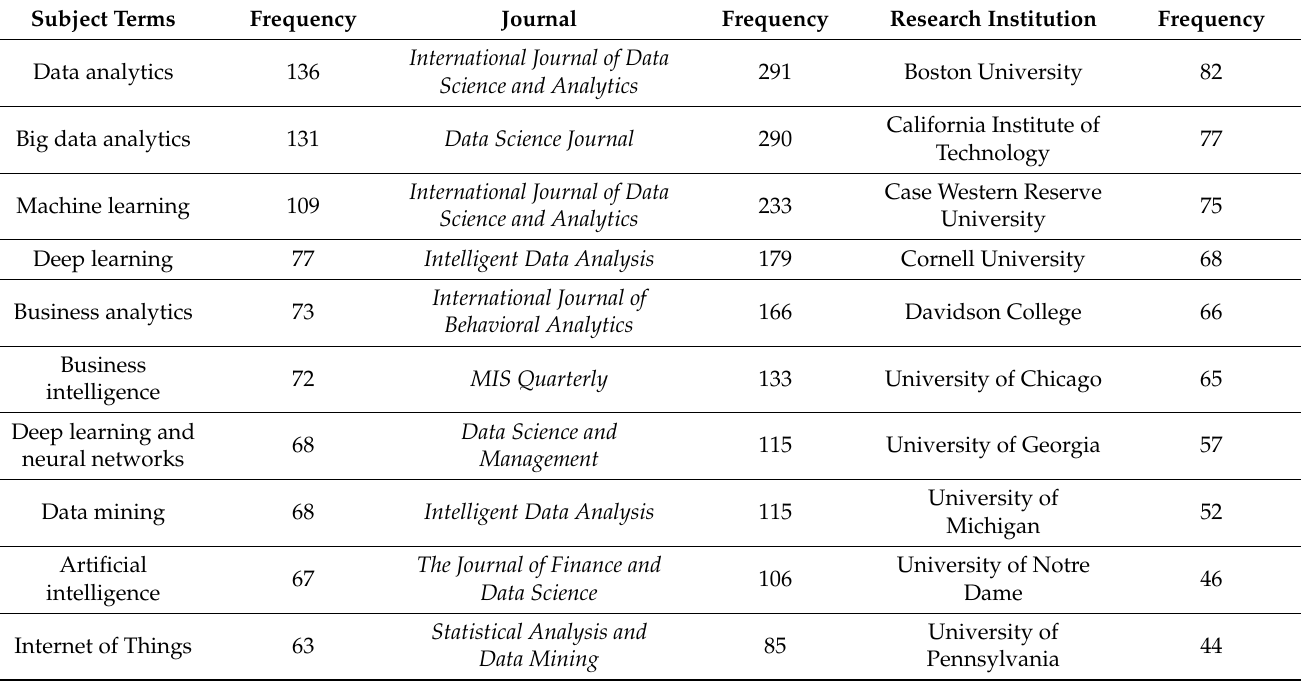
Table 4. Frequency distribution of high-frequency terms, journals, and research